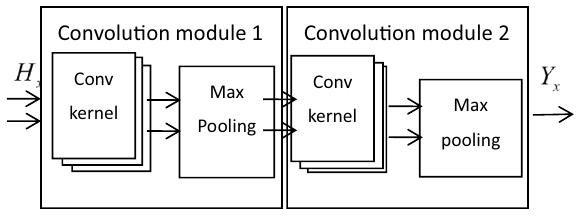
Figure 1. PPG temporal feature extraction